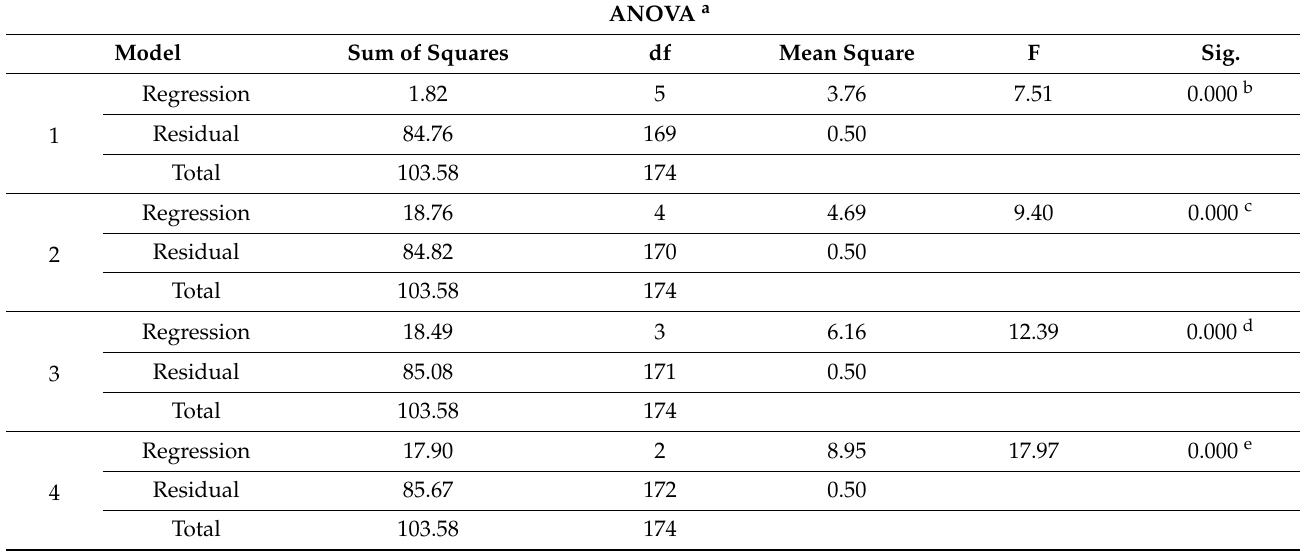
Table 8. Multiple linear regression: